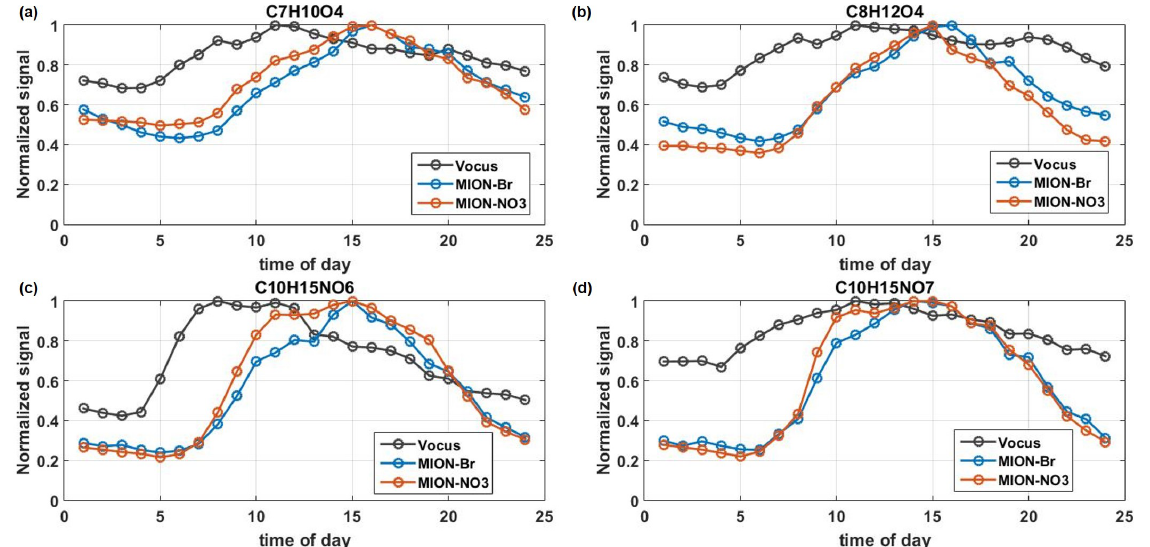
Figure 5. The median diurnal patterns of C 7 H 10 O 4 (a) , C 8 H 12 O 4 (b) , C 10 H 15 NO 6 (c) , and C 10 H 15 NO 7 (d) measured by Vocus, MION-Br, and MION-NO 3 during the whole measurement period. Signals were normalized to their maximum values.